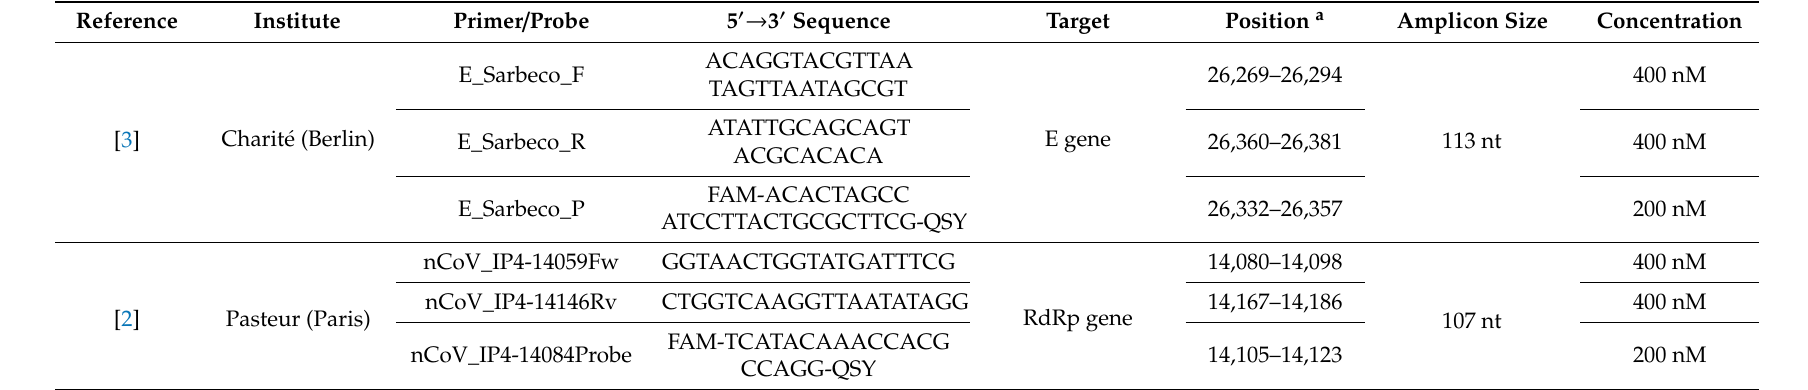
Table 1. Primers and probe included in the duo severe acute respiratory syndrome coronavirus 2